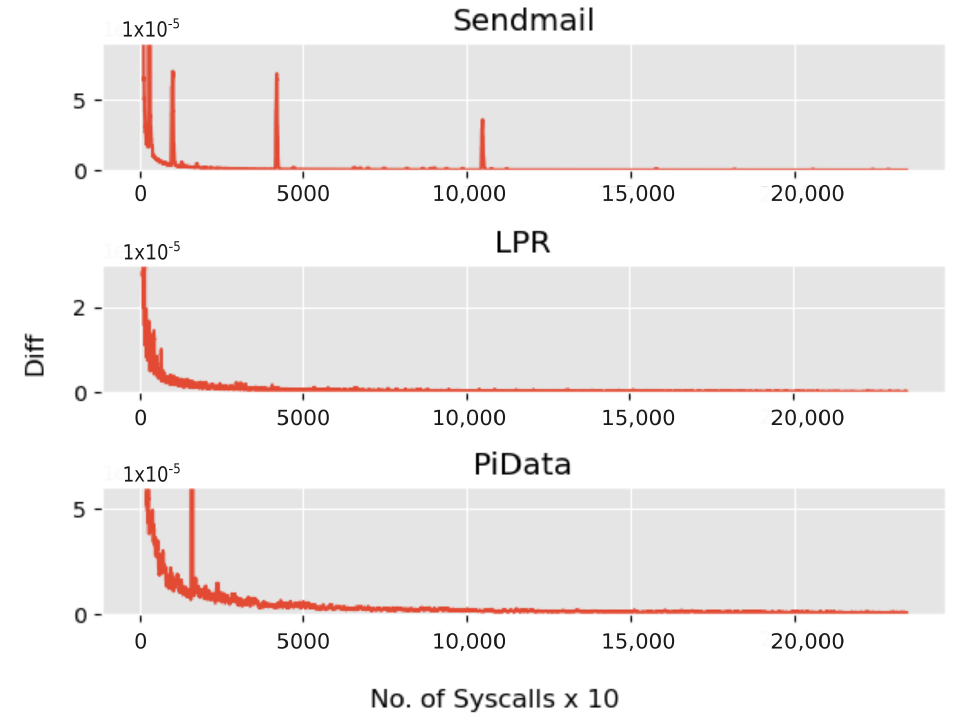
Figure 6. Markov chain